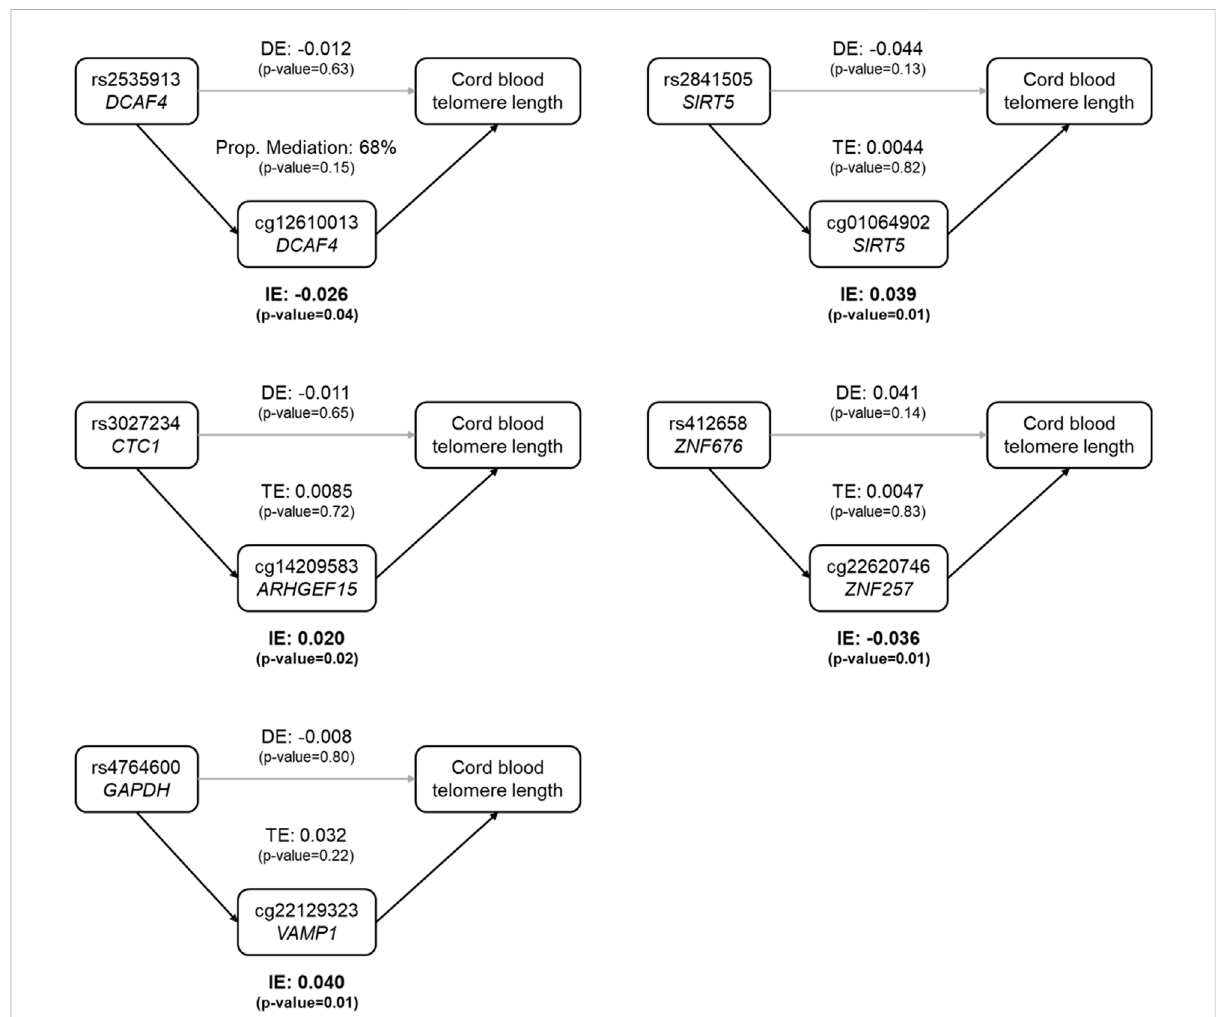
FIGURE 1 Estimated proportion of the association between SNP genotypes and cord blood telomere length mediated by the DNA methylation level at a CpG. In each sub- fi gure, the estimate of the indirect effect (IE) via the CpG, and the estimate of the direct effect (DE) of the SNP on cord blood telomere length are displayed. For the fi rst SNP-CpG pair (rs2535913 and cg12610013, top left), where IE and DE were in the same direction, the proportion of mediation (IE/DE + IE) was shown. In the other 4 mediation relationships, IE and DE had opposite directions, and therefore only the total effect (TE) was shown. Grey arrows stood for insigni fi cant associations, while black arrows denoted the statistically signi fi cant ones (at a nominal signi fi cance level of 0.05). Dominant coding of SNPs was used and the mediation model was adjusted for newborn ’ s sex, gestational age, ethnicity and birth weight, maternal pregnancy complications, pre-pregnancy BMI, parity, education level and smoking status, paternal age, and estimated cell type